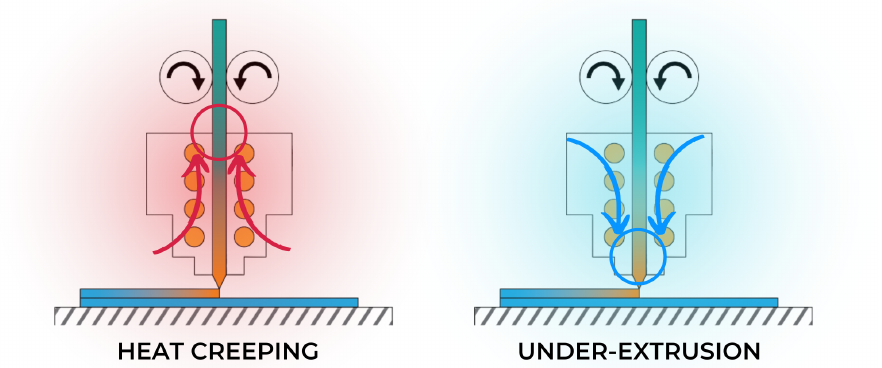
Figure 2. Overheating of plastic can cause a phenomenon called “heat creeping” where plastic tends to go back up due to the high temperature and causes clogging. Under-extrusion is the result of underheating, wherein the filament towards the nozzle solidifies and causes